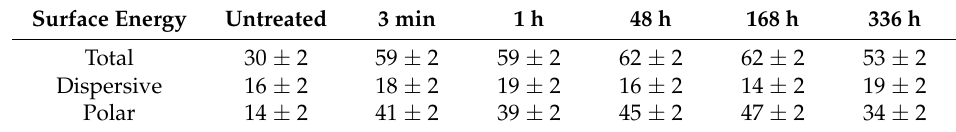
Table 1. Effect of atmospheric pressure plasma torch (APPT) treatment on acrylonitrile-butadiene- styrene (ABS) surface energy components (mJ·m − 2 ) with aging.